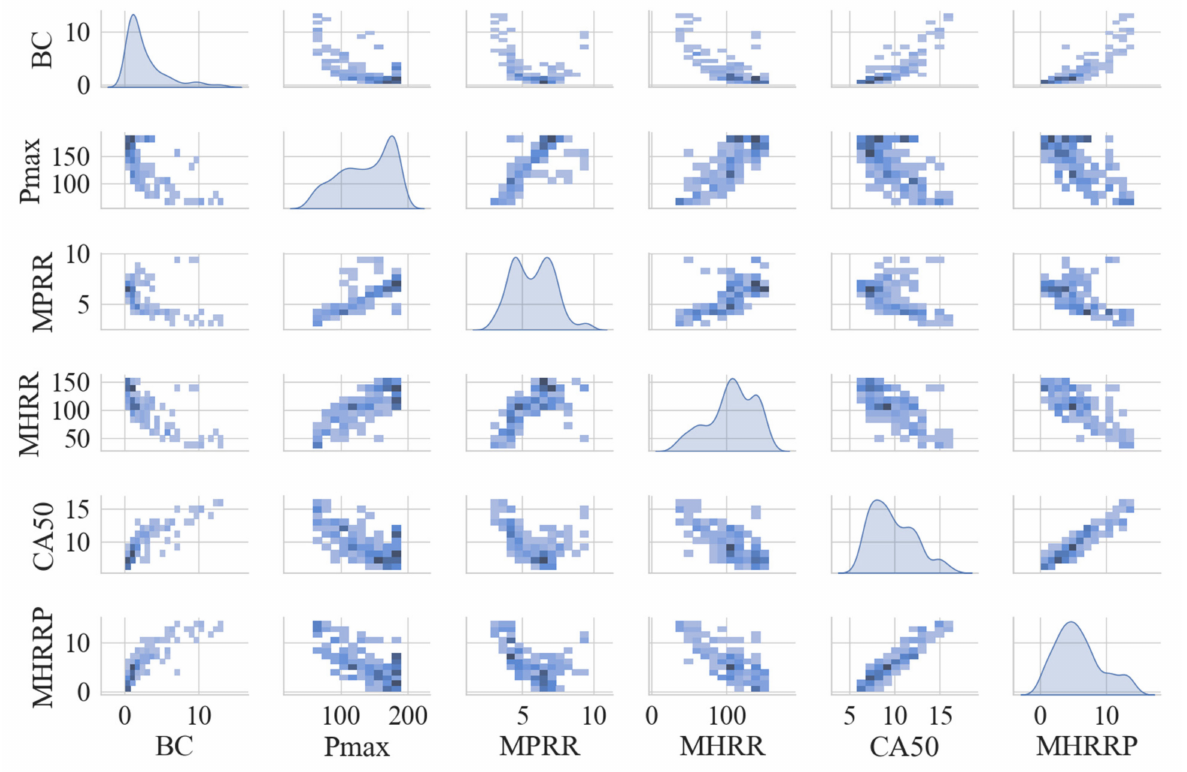
Figure 9. Distribution of the relationship between CCPs and